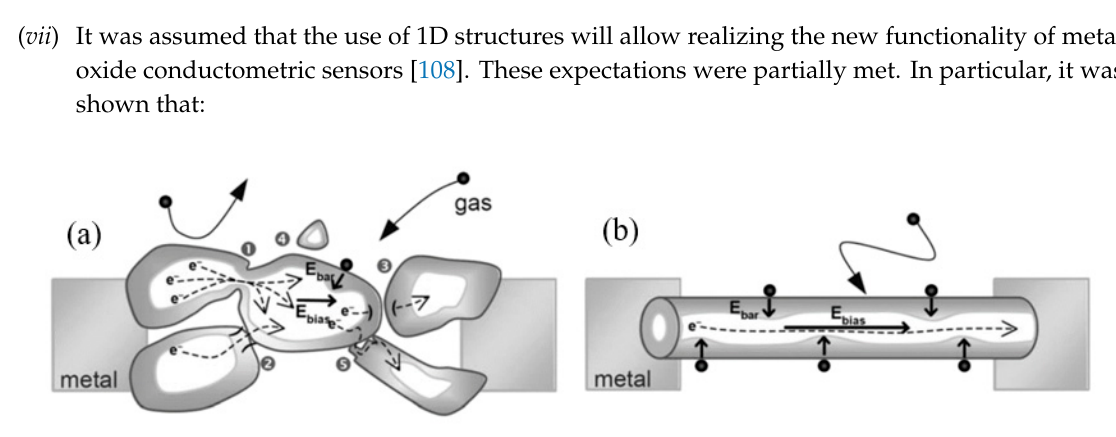
Figure 6. ( a ) The sensor setup and principal thermal losses in the suspended nanowire heated by the Joule heat: P L -losses to the contacts, P G - losses to the ambient gas, and P R -radiation losses; ( b ) SEM image of the suspended SnO 2 chemiresistor. Reproduced with permission from Strelcov et al. [168]. Copyright 2009: American Institute of Physics.